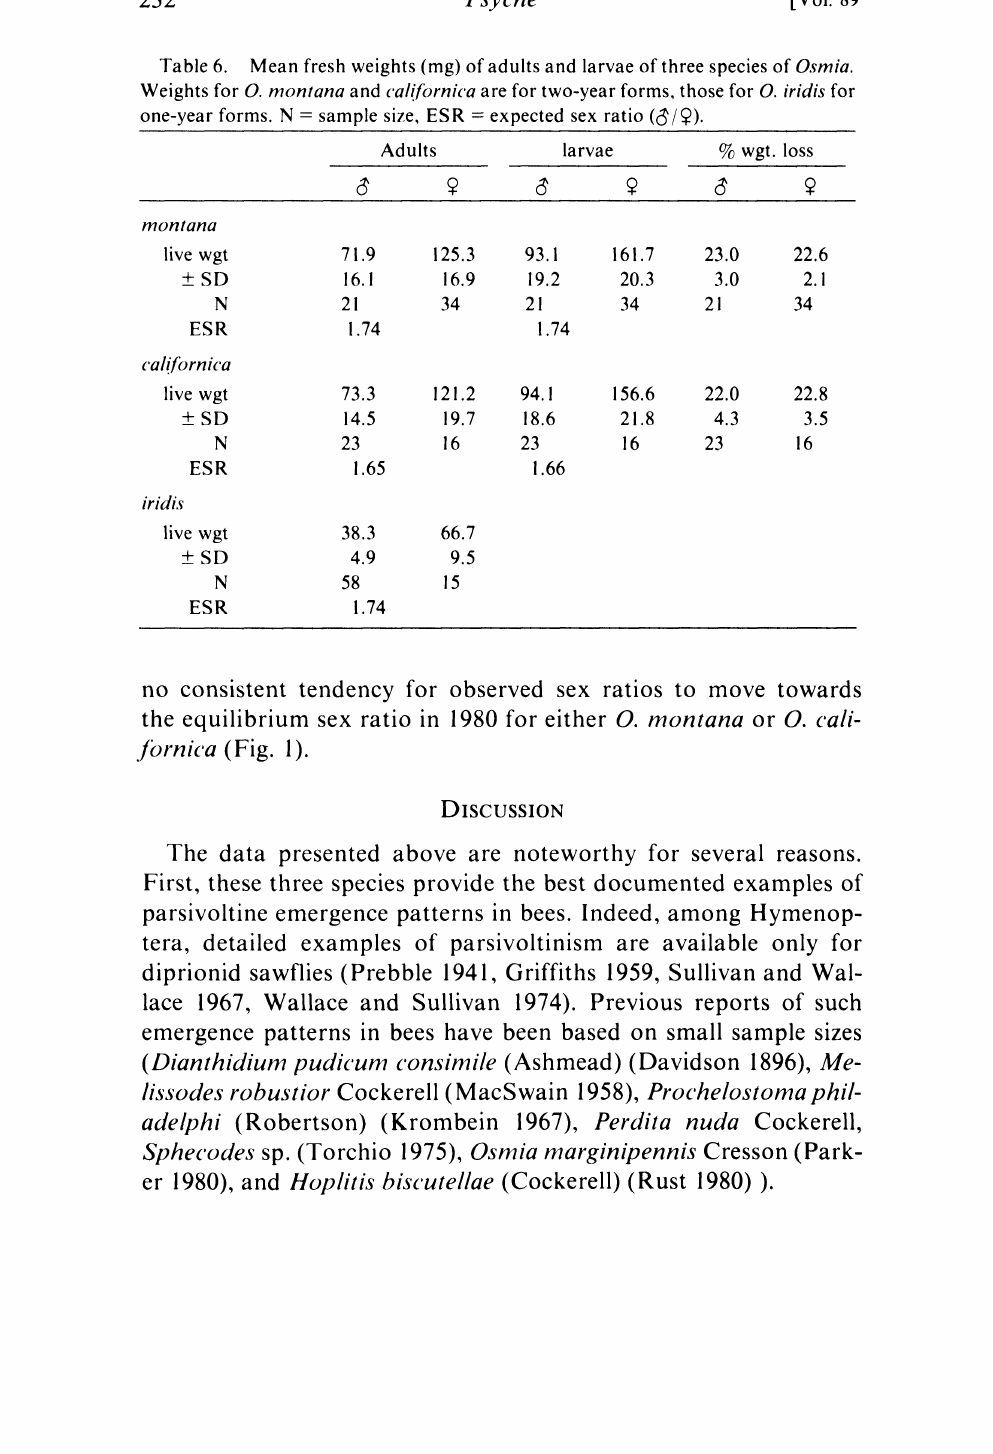
Table 6. Mean fresh weights (mg) of adults and larvae of three species of Osmia. Weights for O. montana and cal(fornica are for two-year forms, those for O. iridis for one-year forms. N sample size, ESR expected sex ratio (/). Adults larvae % wgt.